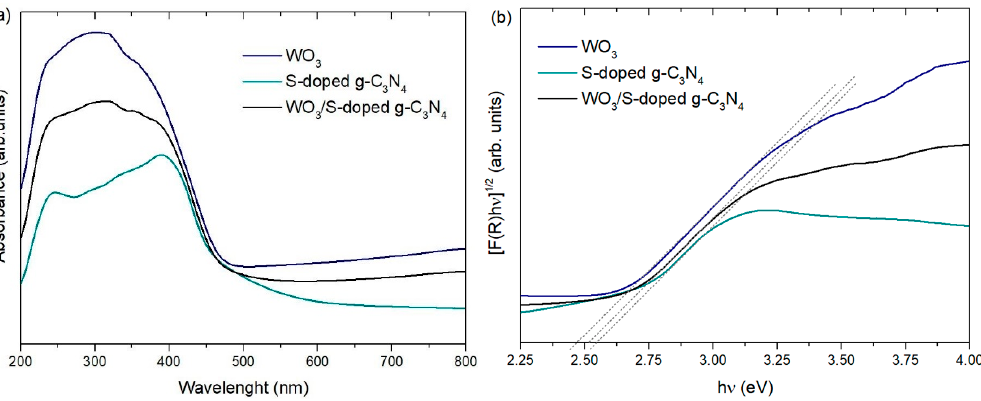
Figure 6. ( a ) DR/UV–vis spectra and ( b ) the Kubelka–Munk transformation of obtained samples.